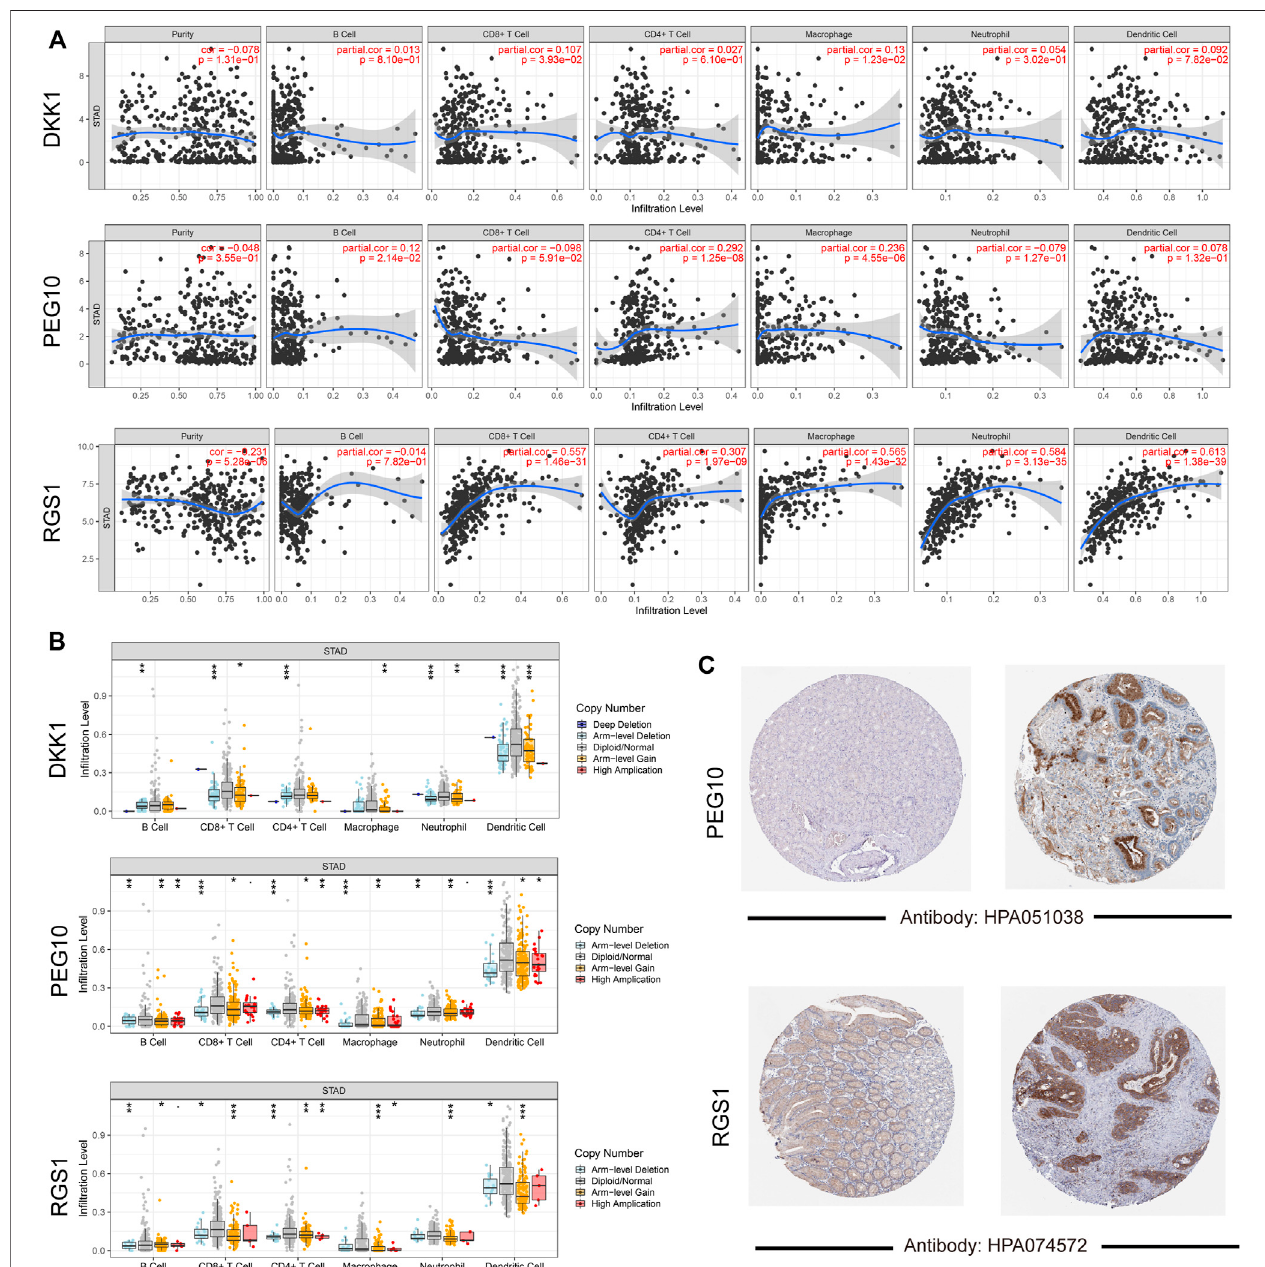
FIGURE6| Validationforsignaturegenes. (A) Correlationsgeneexpressionlevelwithtumor purityandsiximmunecellsin fi ltration; (B) thedifferencesonin fi ltration levels among different copy number status; (C) the immunohistochemistry images showed the protein expression of PEG10 and RGS1.